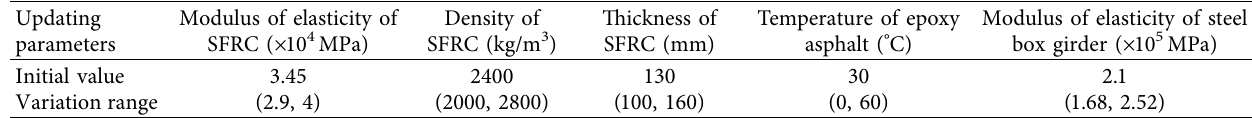
Figure 6: Measured bridge vibration modes. (a) First-order asymmetric vertical bending (3.77Hz). (b) First-order symmetric vertical bending (4.99 Hz). (c) First-order symmetric torsion (5.30 Hz). (d) First-order asymmetric reversal (7.47 Hz). (e) Second-order symmetric torsion (11.96Hz). (f) Second-order asymmetric reversal (14.95Hz). Table 2: Range of updated structural